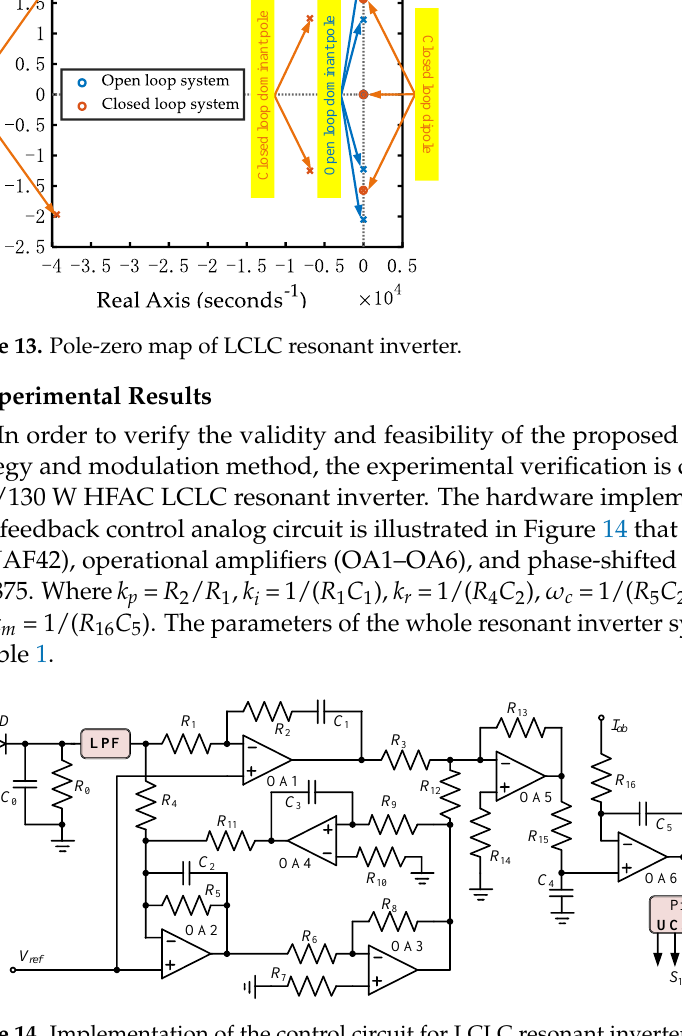
Figure 14. Implementation of the control circuit for LCLC resonant inverter. Table 1. The parameters of the inverter prototype system.